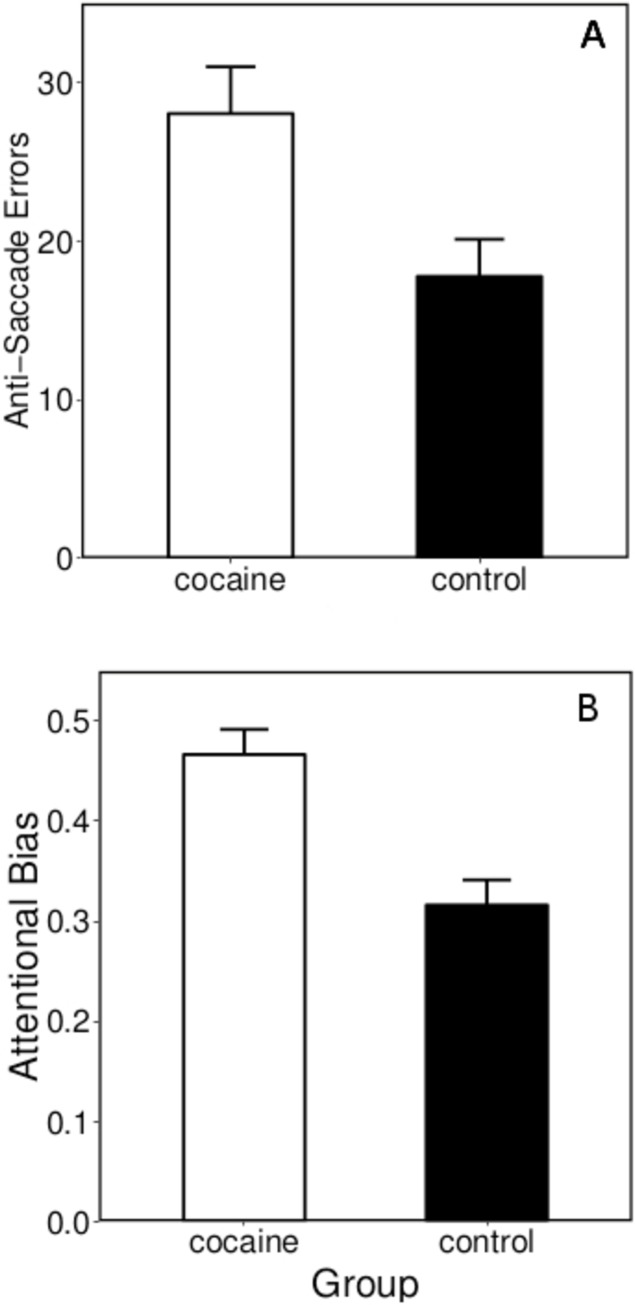
Anti-saccade performance of CUD/AUD subjects and control subjects on the cocaine eye-tracking task.Panels A and B show mean total anti-saccade errors and attentional bias scores (± SEM), respectively. The attentional bias score was calculated as anti-saccade errors on cocaine-stimulus trials / total anti-saccade errors on all trials, providing an indicator of attentional bias towards cocaine cues.